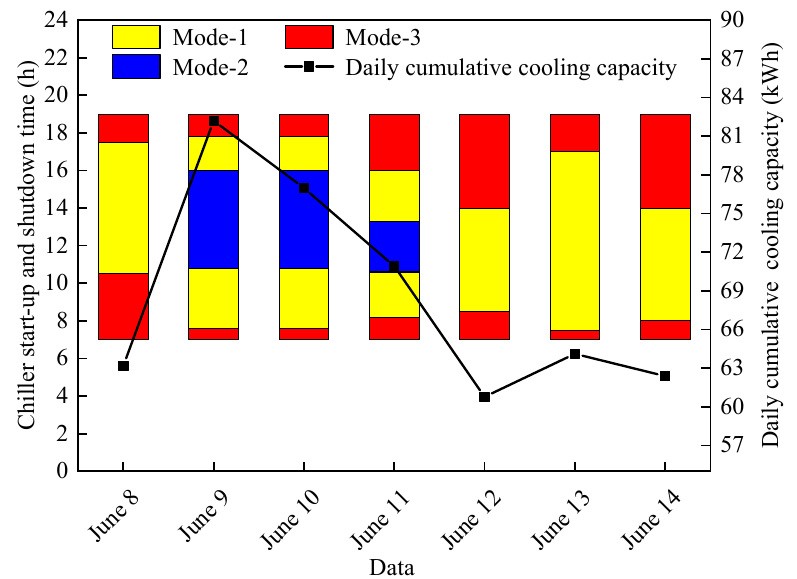
Figure 5. Daily single- and double-effect operation mode switching and daily cumulative cooling capacity of the system with auxiliary